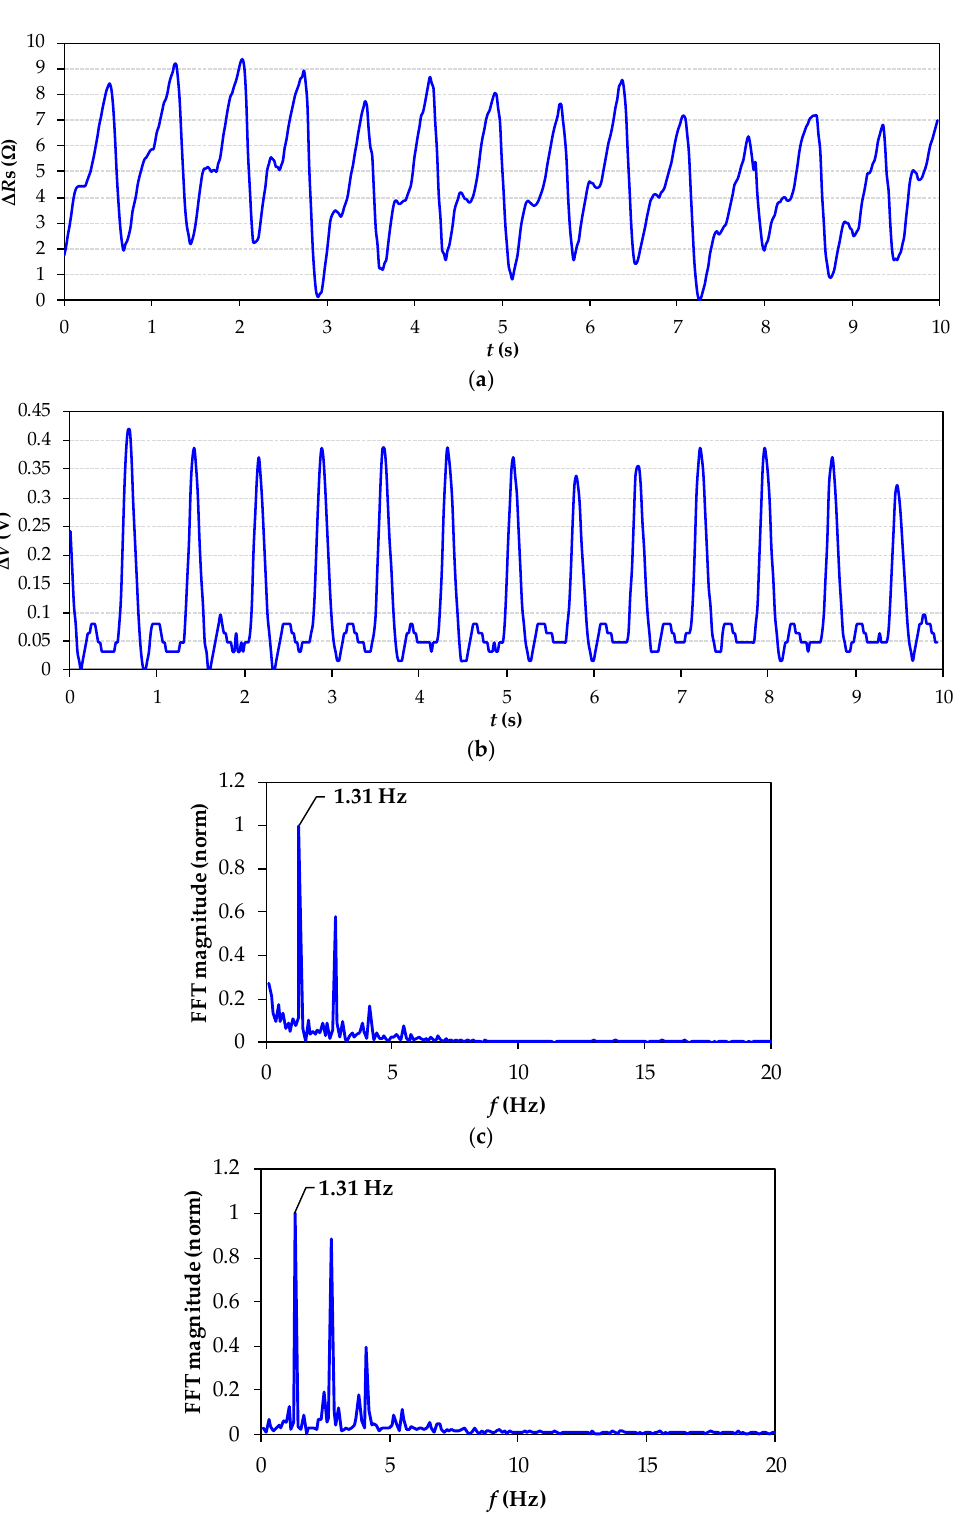
Figure 6. Experimental heartbeat signal from S1. ( a ) Resistance variations in FSR measured by the DIC when the sensor was located near the radial artery; ( b ) voltage variations in the commercial heart rate monitor; ( c ) frequency spectrum of the FSR signal; ( d ) frequency spectrum of the commercial monitor signal.